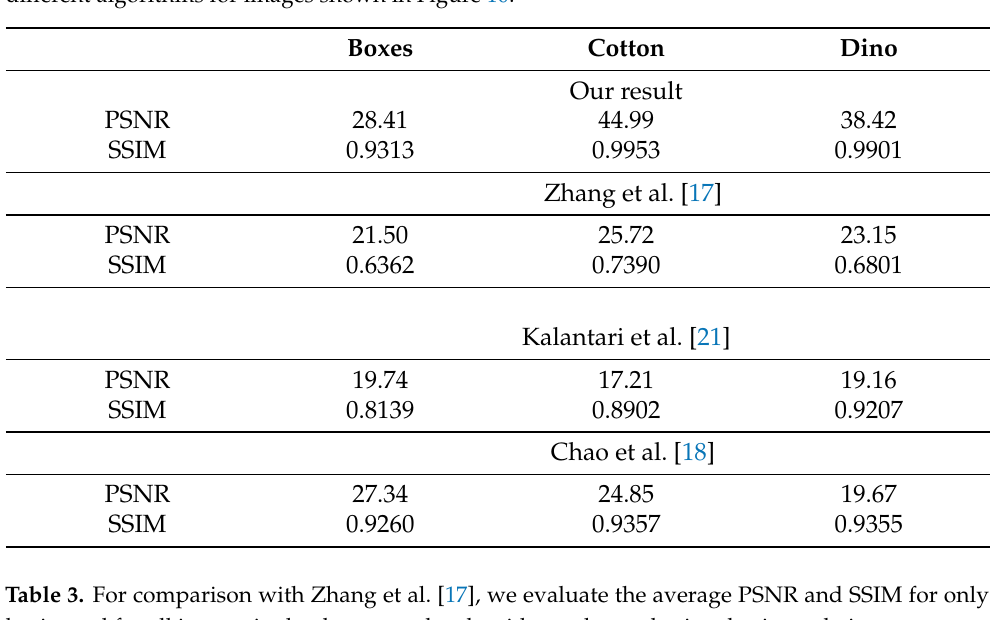
Table 2. Quantitative comparison for leftmost central horizontal synthesized view comparison with different algorithms for images shown in Figure 10.